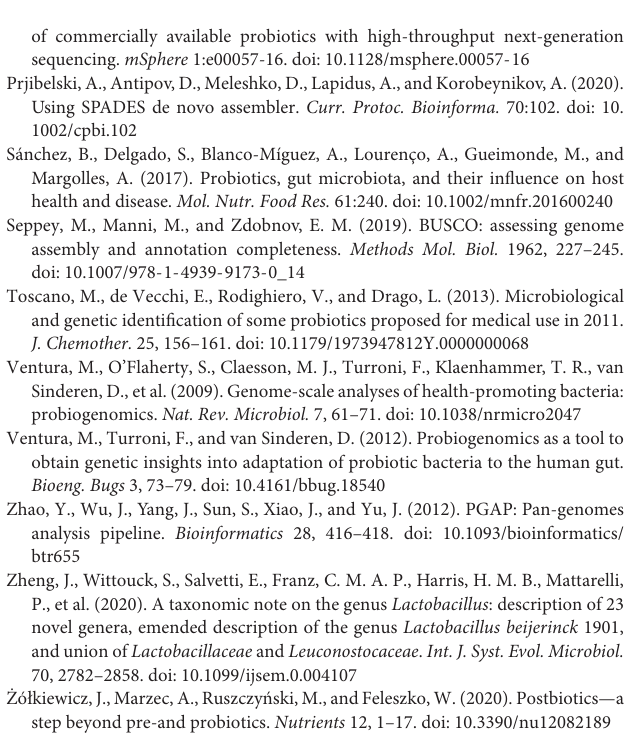
Supplementary Figure 1 | Pangenome-based phylogenetic trees of probiotic strains. Panel (A) shows the pangenome-base phylogenetic tree of B. animalis reconstructed genomes, while panel (B) exhibits the equivalent tree for B. longum probiotic